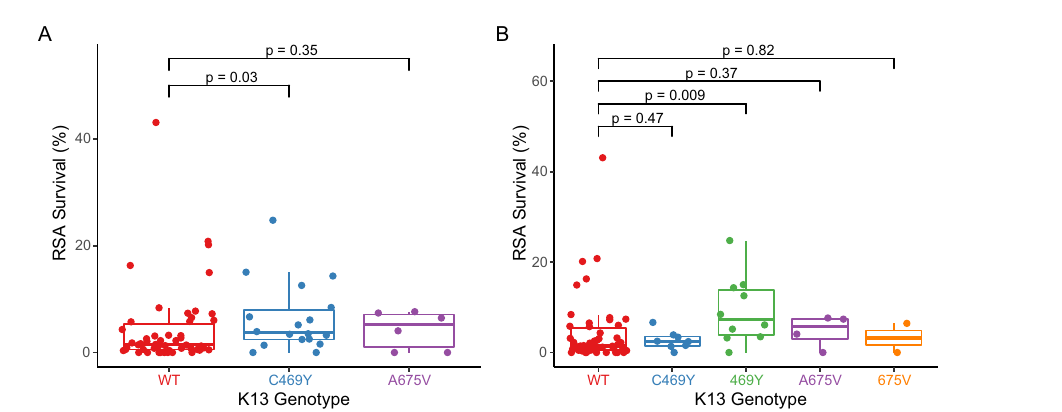
Fig. 3 | Ex vivo ring survival in parasites with different PfK13 genotypes. Each point represents the result for a single isolate ( A n =50 WT, 18 C469Y, 6 A675V; B n =50WT,8C469Y,10469Y,4A675V,2675V).Resultsareshownwithmixedand pure mutant isolates combined ( A ) or shown separately ( B ). P -values were deter- mined using the two-sided Mann – Whitney Wilcoxon test. Center bounds of boxes